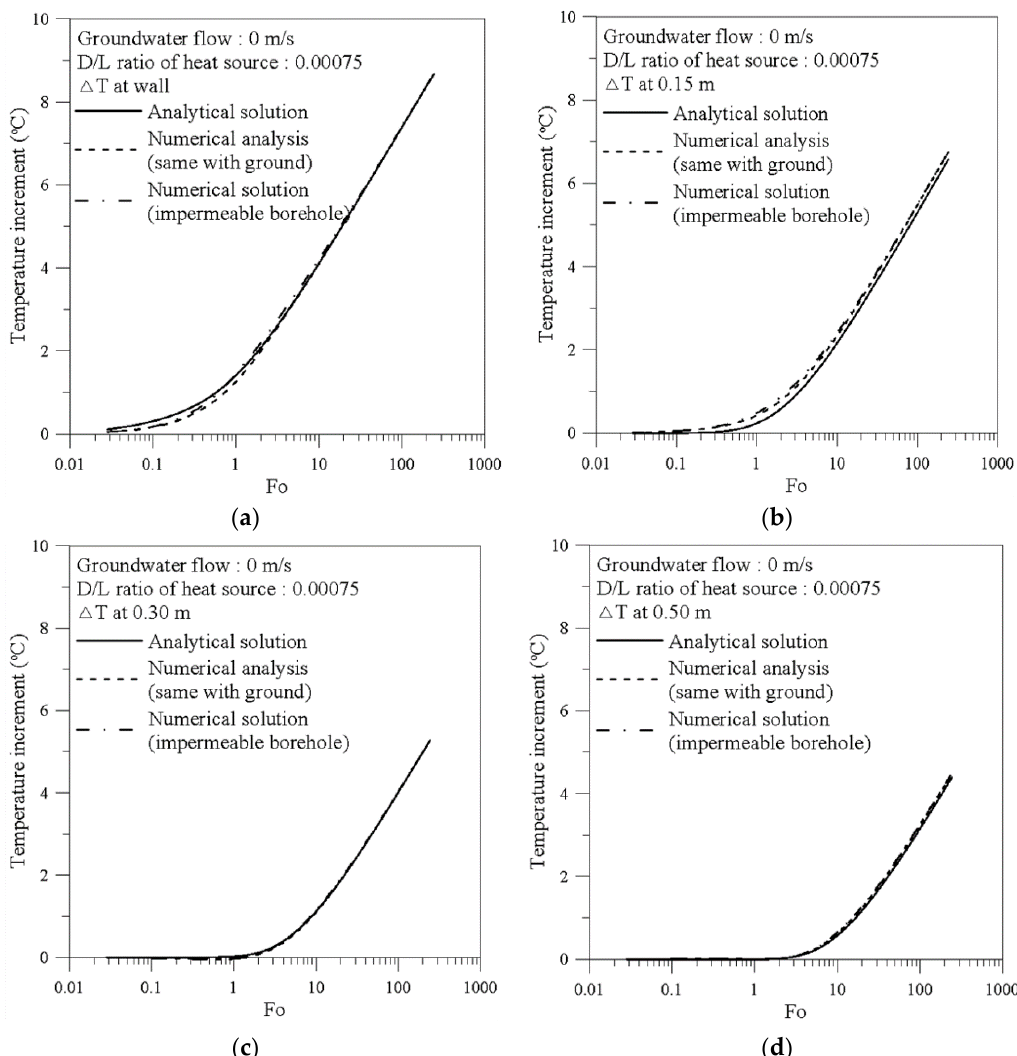
Figure 4. Comparison of analytical solution and numerical analysis results (u = 0 m/s, D/L ratio = 0.00075). Temperature increment at ( a ) wall; ( b ) 0.15 m; ( c ) 0.30 m; ( d ) 0.50 m.